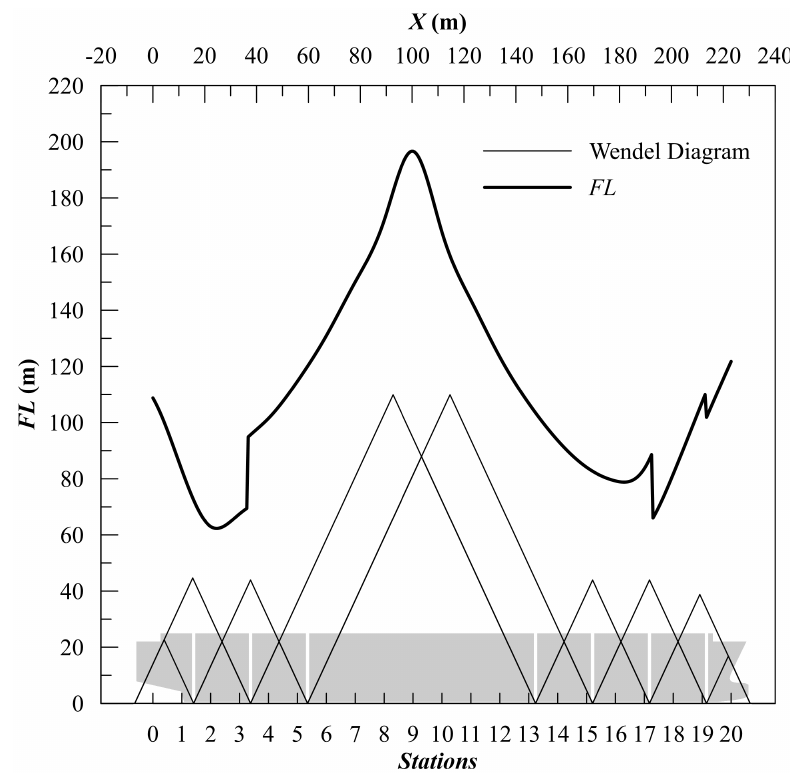
Figure 7. Optimised subdivision: 4 cargo hold case. Table 5. Results of the optimisation